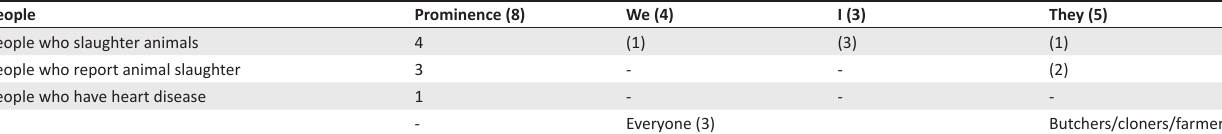
TABLE 2: Thematic prominence of people and related pronoun use. People People who slaughter animals People who report animal slaughter People who have heart